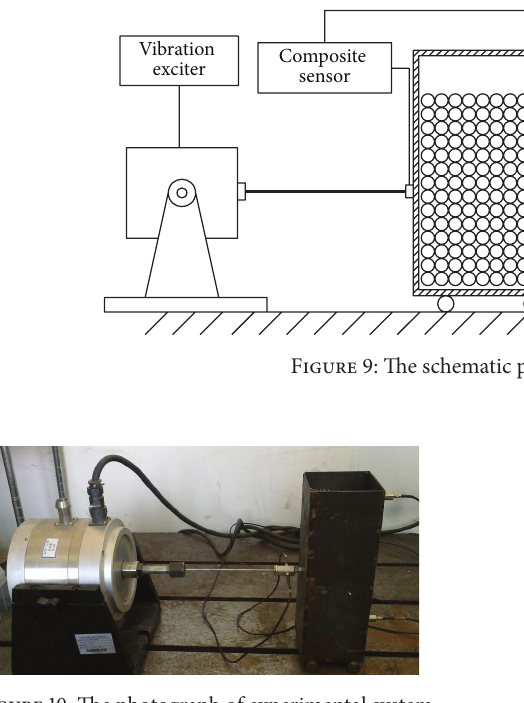
Figure 10: The photograph of experimental system.